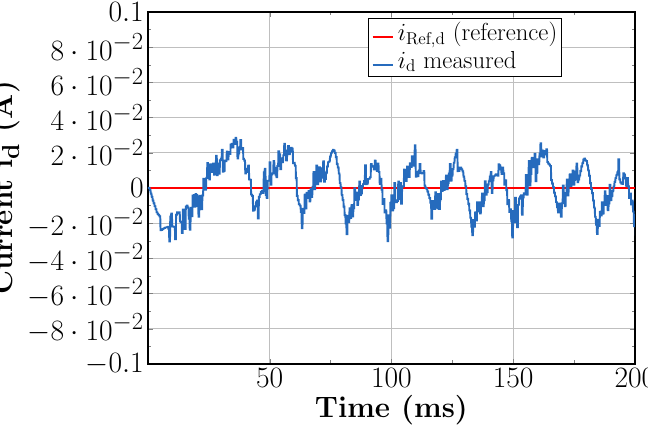
Figure 26. Sensorless speed control for 100 RPM, current on the d-axis.